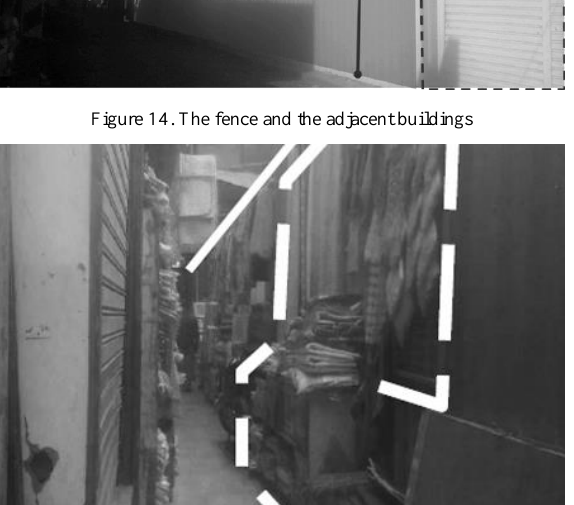
Figure 15. Produced spaces. The white dashed line indicates the produced space. The continuous white line indicates the fence.